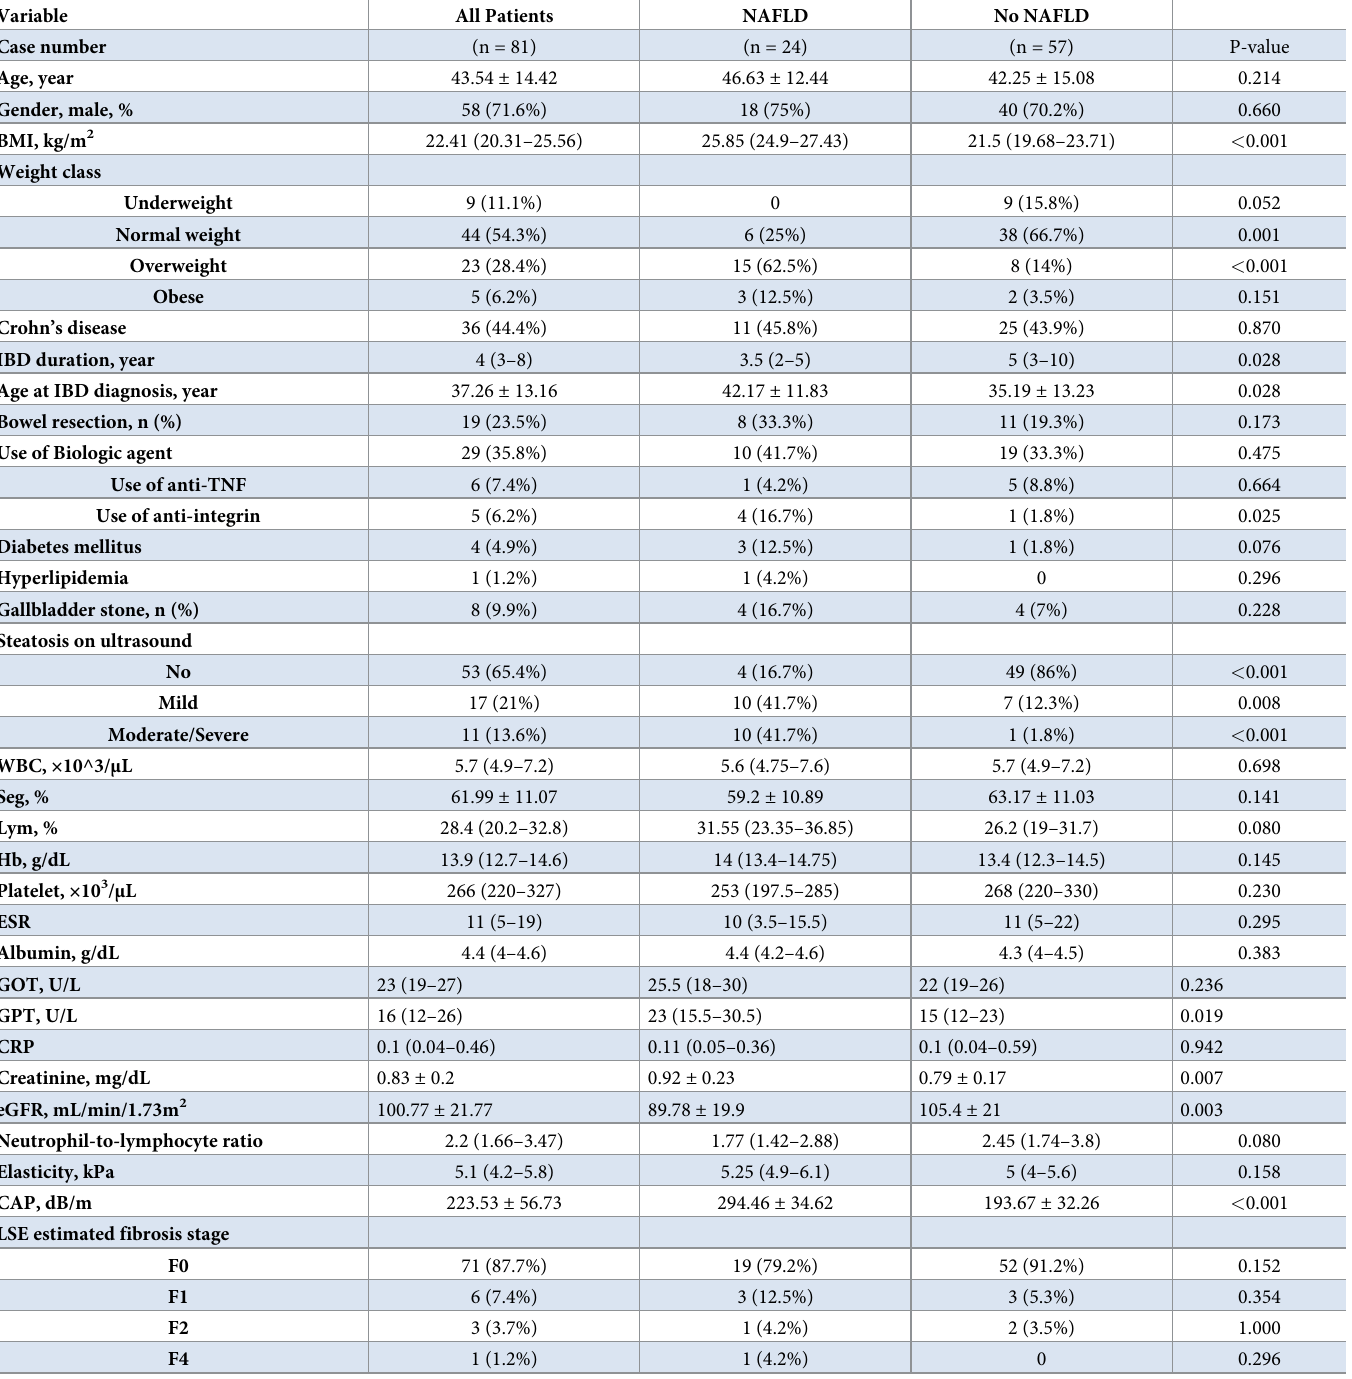
Table 2. Comparison of patient characteristics with and without